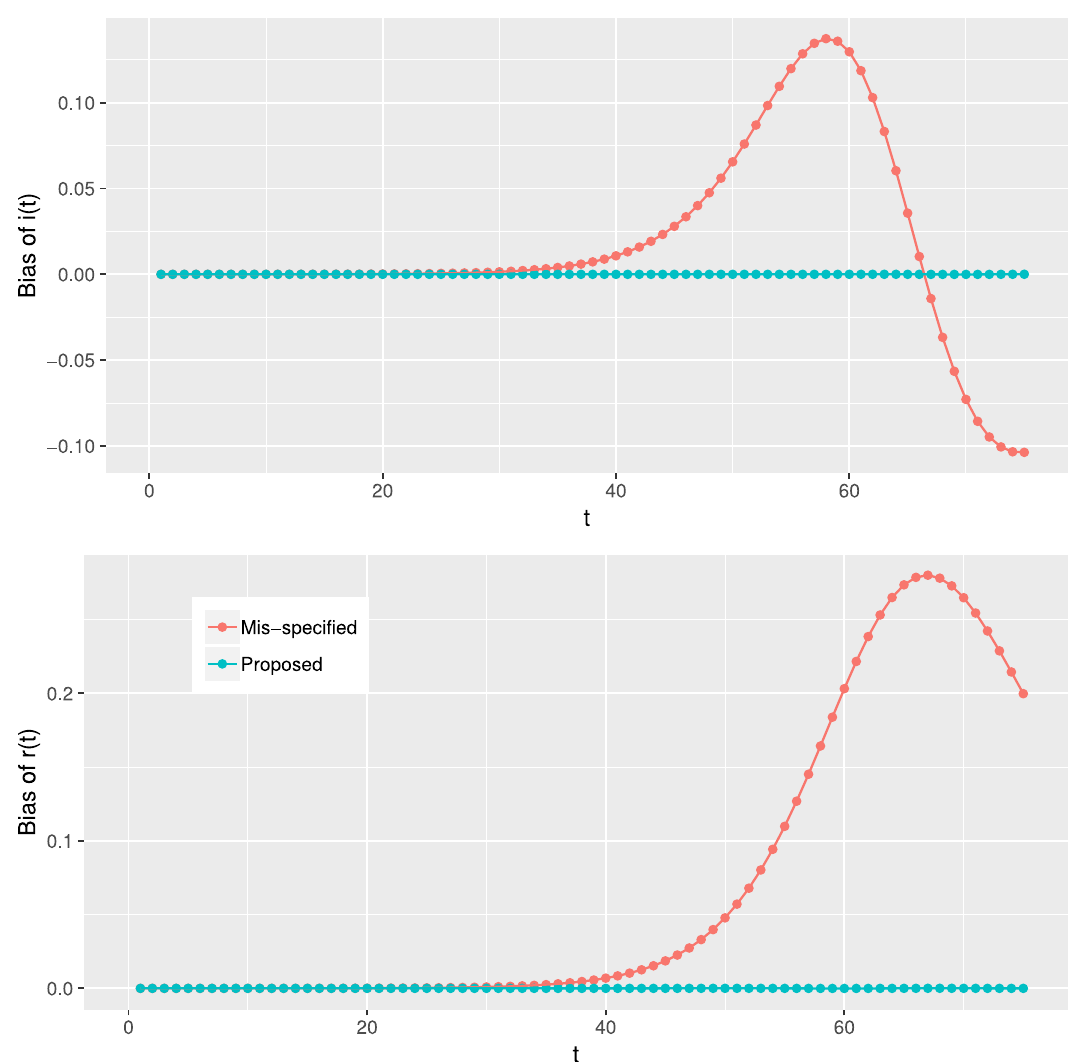
Fig 1. The impact of mis-specification of i 0 and r 0 . Plots of the relative biases of ^ i ð t Þ (upper) and ^ r ð t Þ (lower) when ^ i ð t Þ and ^ r ð t Þ are derived 1) by using the ODE framework with the mis-specified initials (“Mis-specified”) and 2) by using proposed model with mis- specified initials (“Proposed”). In the model, the true ( β , γ ) = ( e − 1 , e − 1.95 ) and ( i 0 , r 0 ) = (10 − 6 , 10 − 6 ). These values are roughly equal to the constant estimates of the real situation. The mis-specified initials are set as (5 × 10 − 6 , 5 × 10 − 6